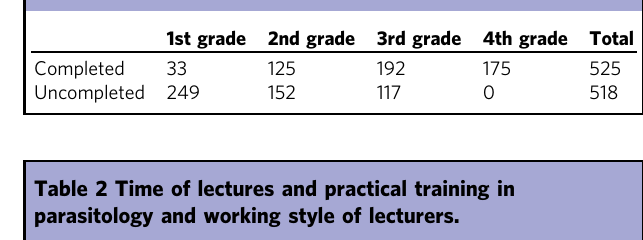
Table 1 Af fi liations and grades of students who participated in this study.